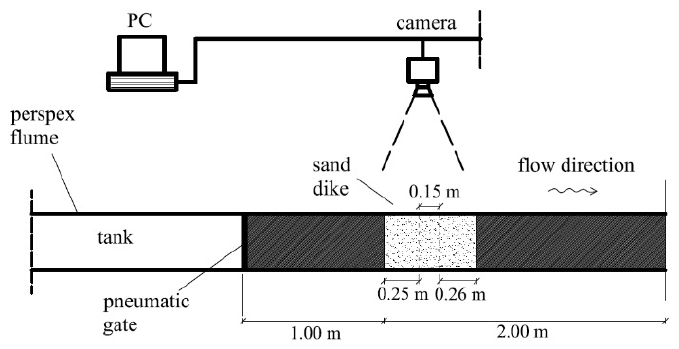
Figure 2. Sketch of the laboratory setup (overtop